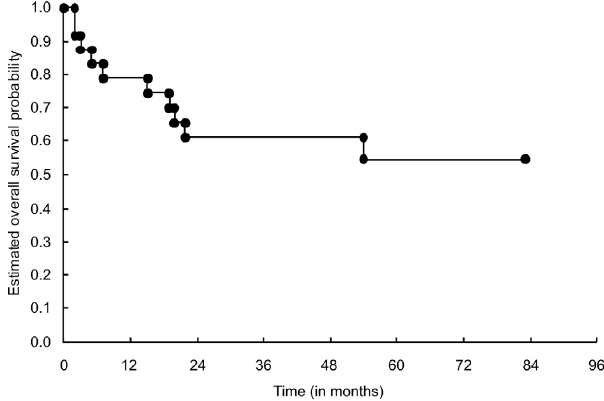
Figure 10 - Curve of overall survival in months for the 24 patients with primary osteosarcoma that was non-metastatic at diagnosis